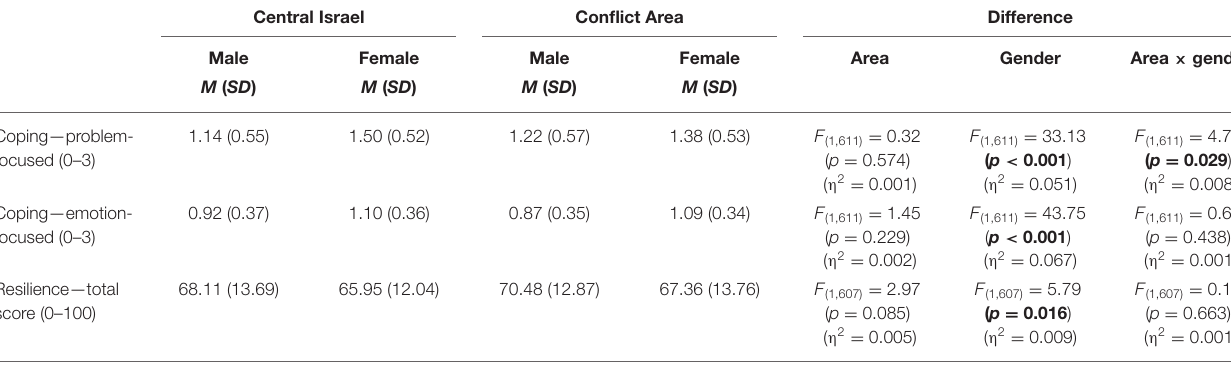
TABLE 2 | Distribution of coping and resilience by area and gender ( N = 615).